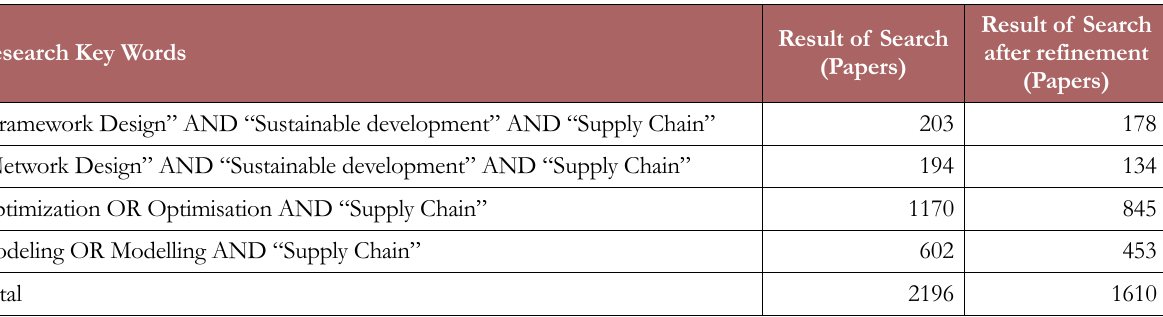
Table 2. The initial researching result before and after refinement